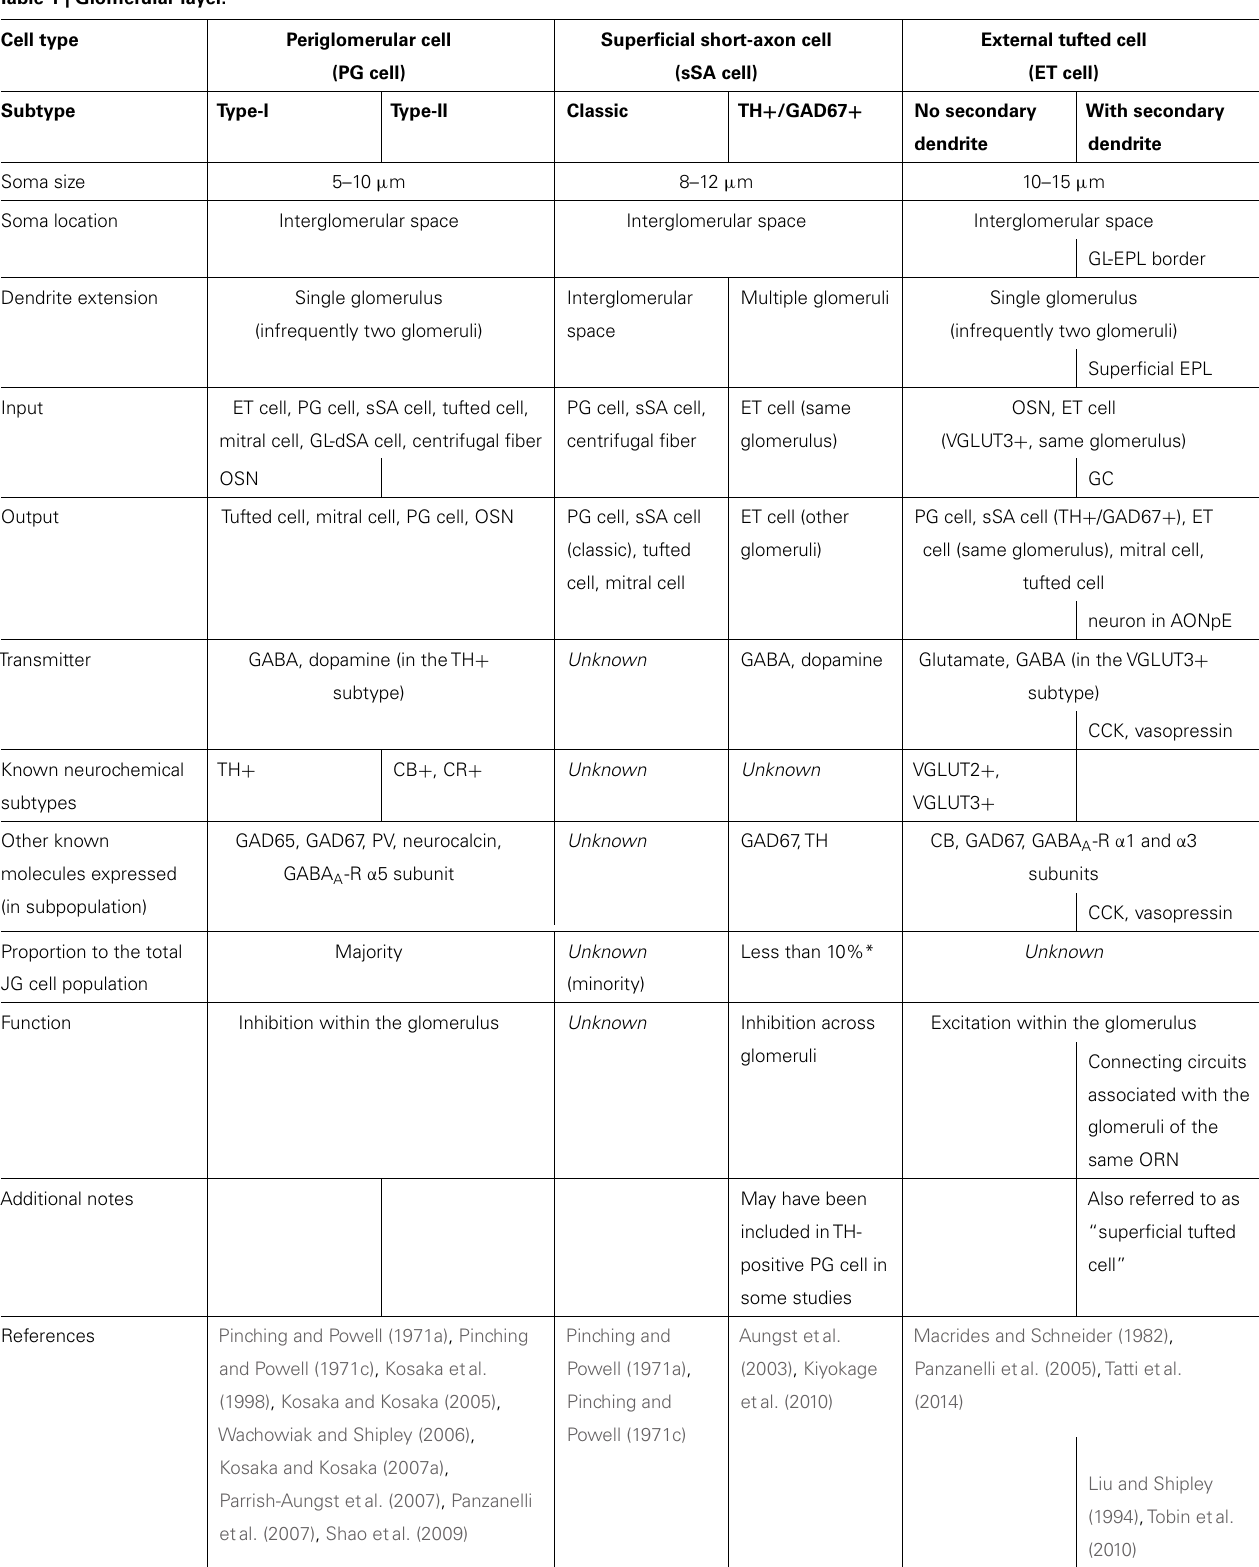
Table 1 | Glomerular